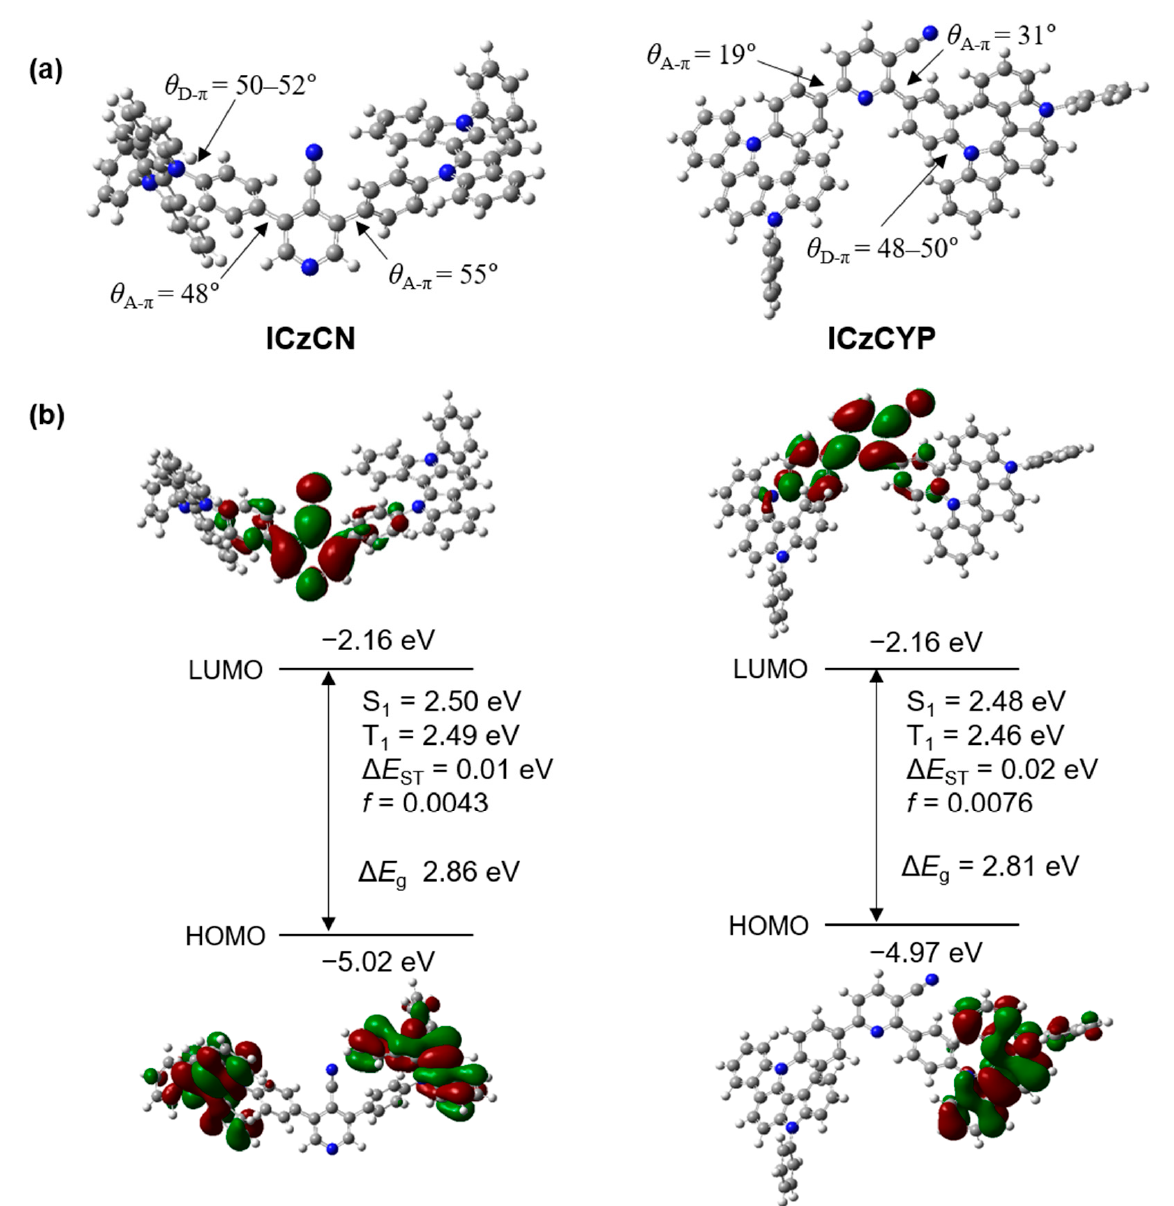
Figure 1. Optimized chemical structures and energy levels of S 1 and T 1 states and frontier orbital distributions of ( a ) ICzCN and ( b ) ICzCYP .